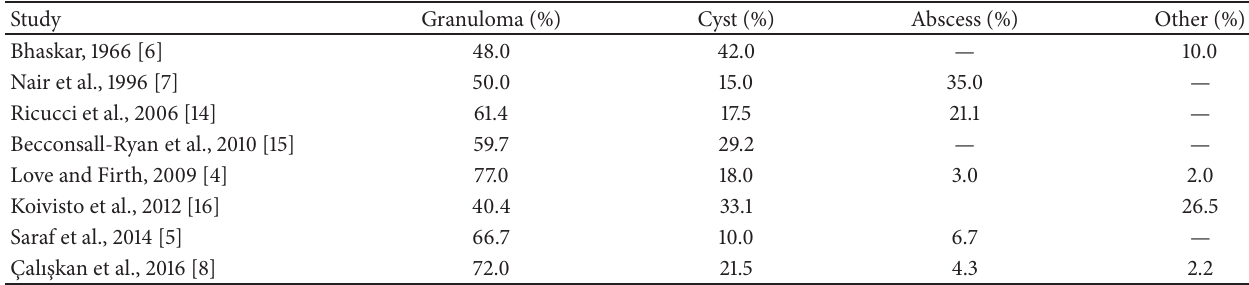
Table 1: Distribution of chronic periapical lesions as reported in various